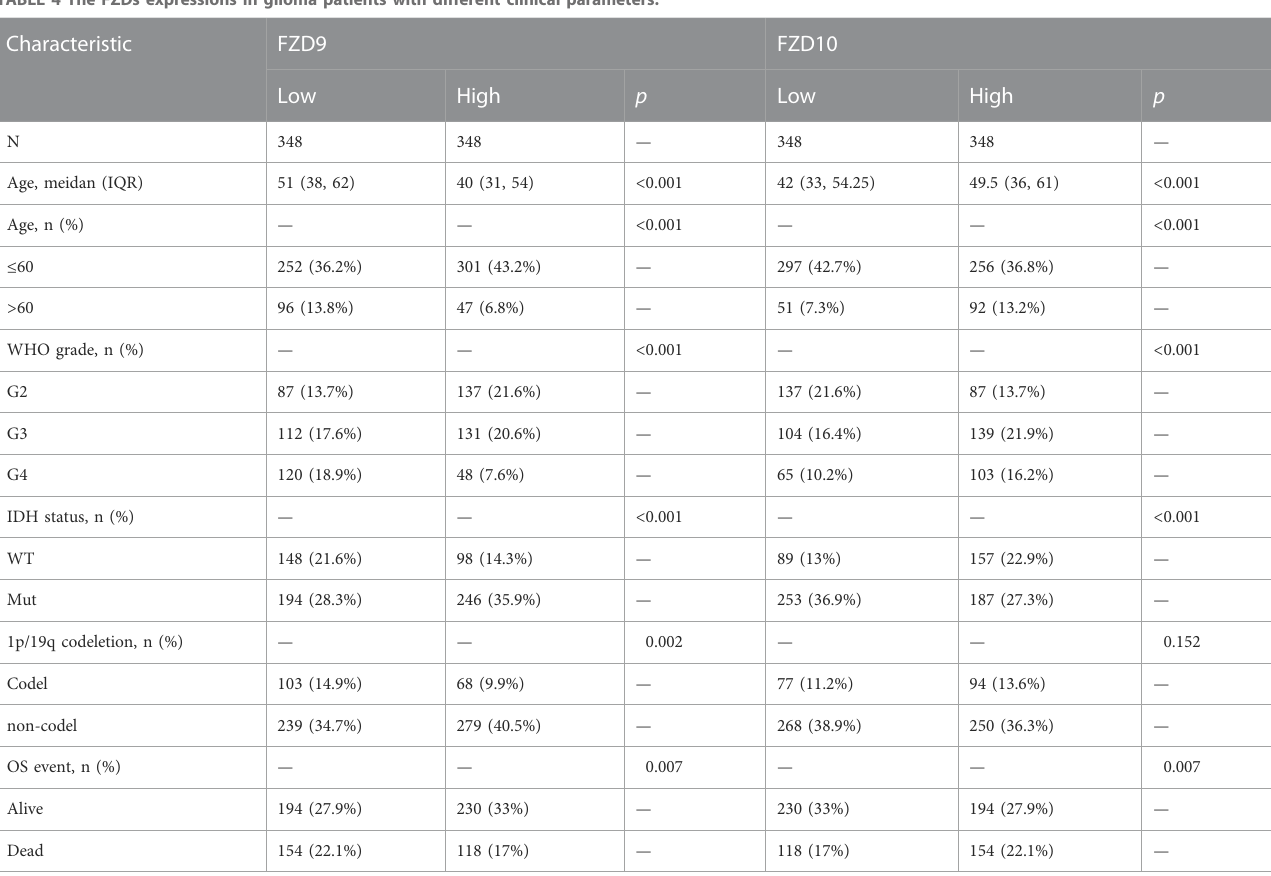
TABLE 4 The FZDs expressions in glioma patients with different clinical